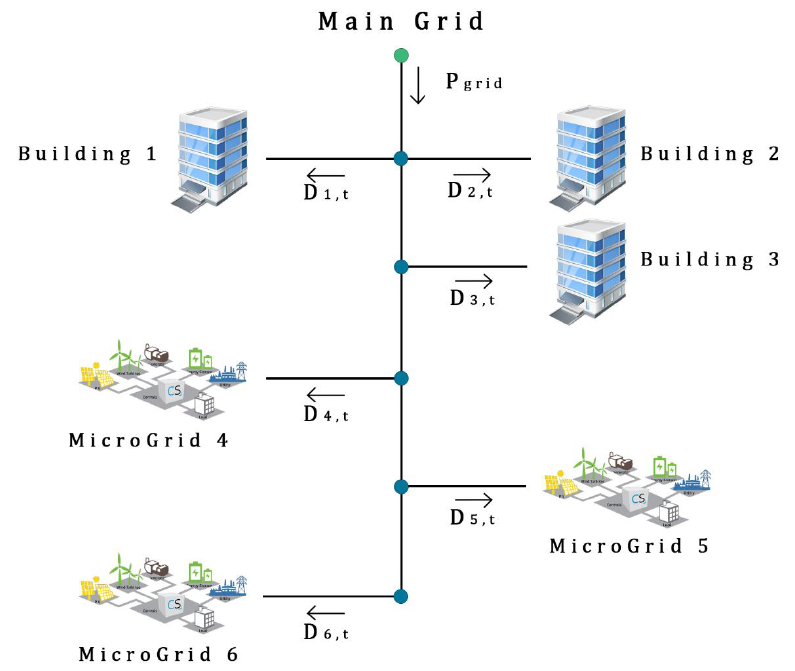
Figure 3. Network architecture of the case study.